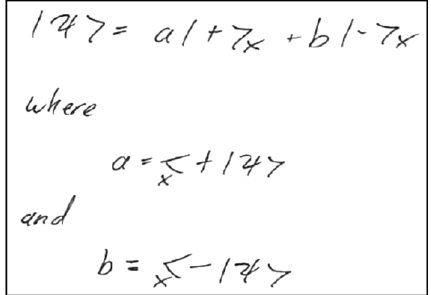
FIG. 4. A student ’ s written response when asked to write the general form of a state in the S x basis. Here the student uses two unknown variables, a and b , and connects the coefficients to the appropriate inner